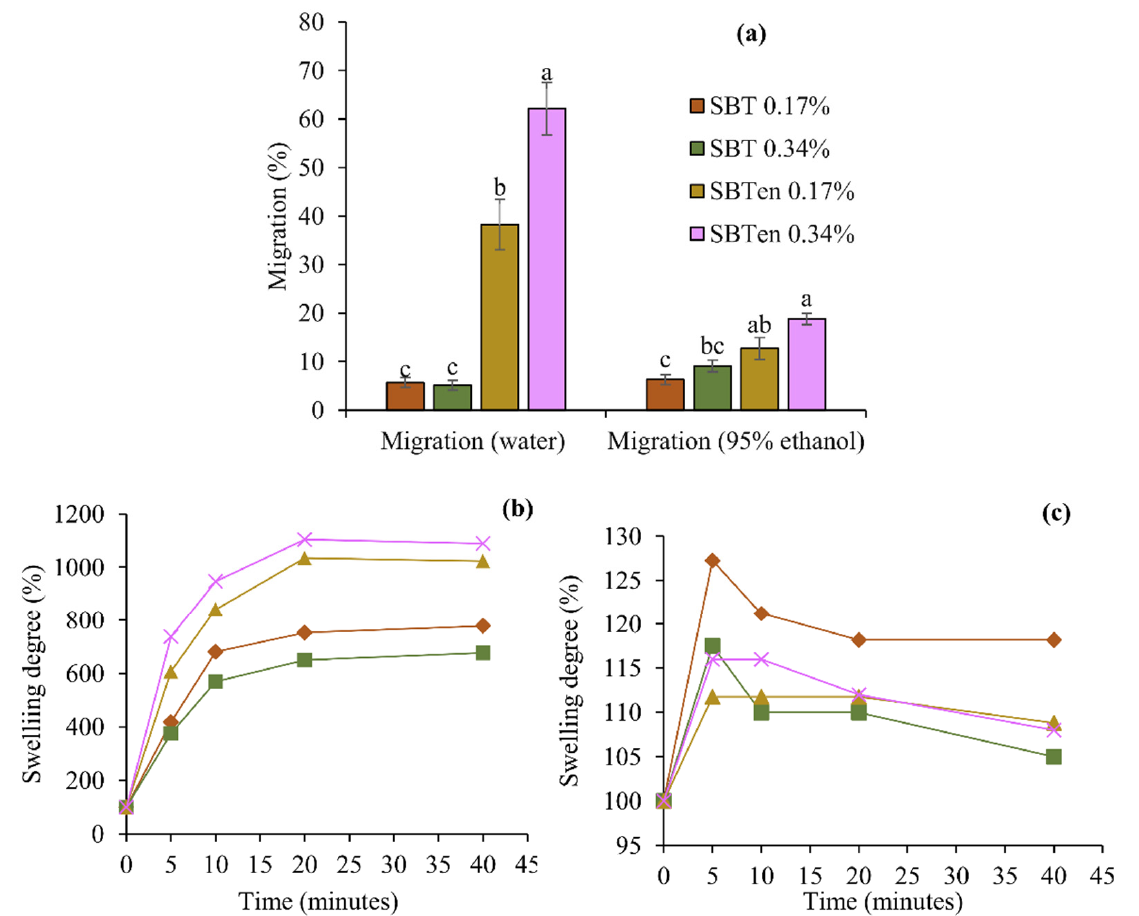
Figure 5. Migration percentage of antioxidant compounds into water and 95% ethanol, ( a ) Swelling degree in water ( b ) and Swelling degree in 95% ethanol ( c ) of starch films incorporating free or encapsulated SBT extracts at 0.17% or 0.34%. Different letters in each food simulant (a–c) indicated a statistically significant difference ( p < 0.05).2.7. Effect of Antioxidant Activity on Preventing Li- pid Oxidation.